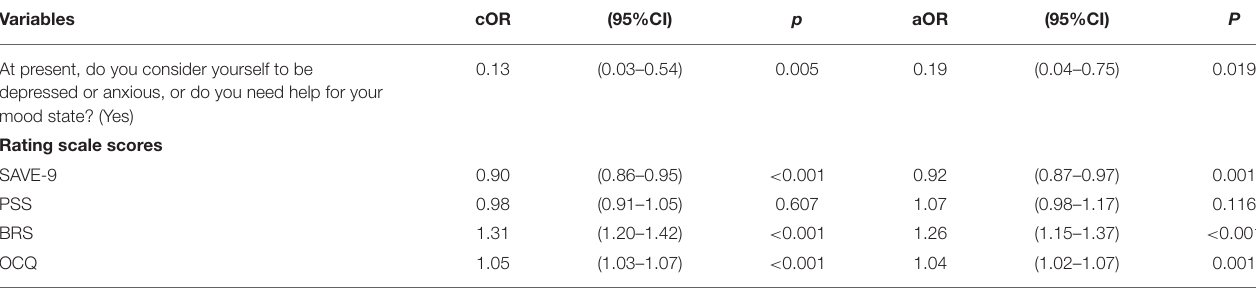
TABLE 4 | Logistic regression analysis for predicting High QOL (WHO-5, top 25%) in healthcare workers during the COVID-19 pandemic